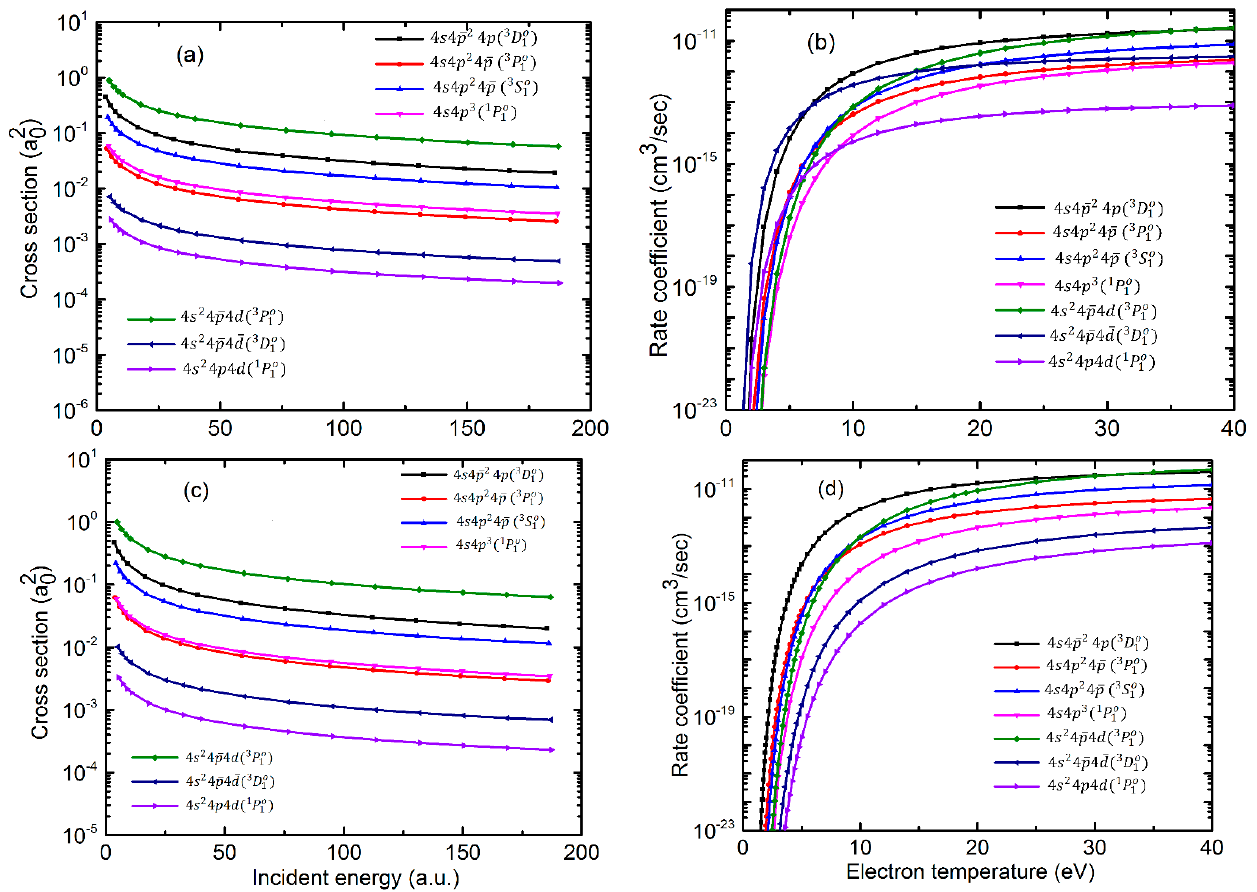
Figure 3. Integrated cross section vs incident electron energy (left panel) and excitation rate coefficients vs electron temperature (right panel) for ( a , b ) In 17+ , and ( c , d ) Cd 16+ ions.